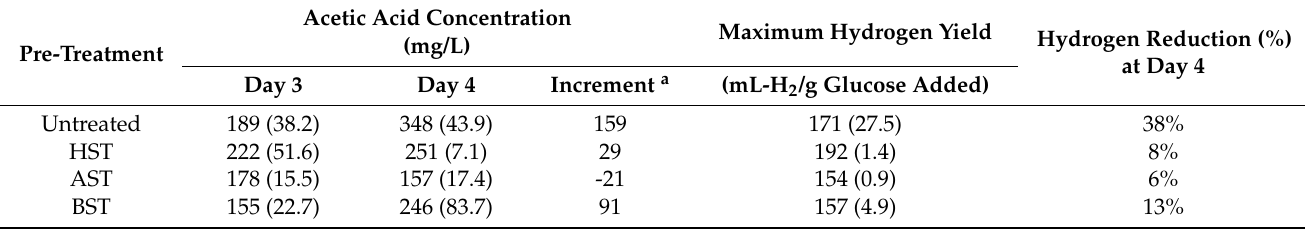
Table 5. The effect of acetic acid on hydrogen production during 5-day BHP tests.